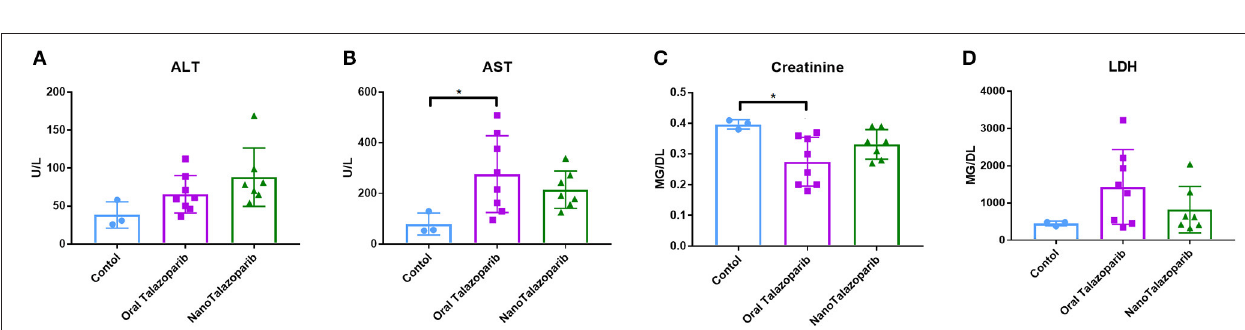
Frontiers in Oncology |